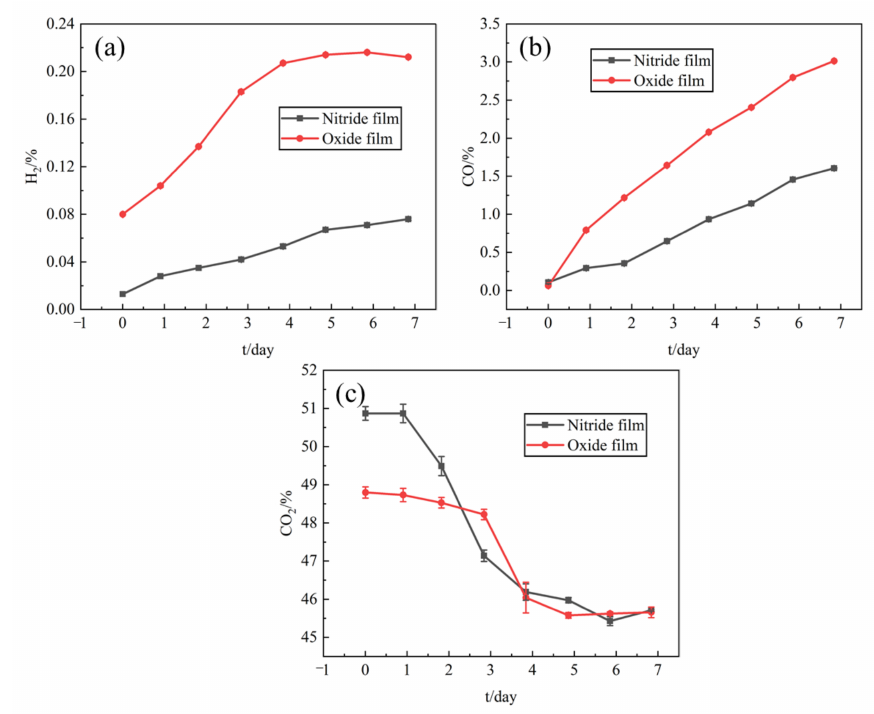
Figure 10. Variation of H 2 , CO, and CO 2 content with time of different films. ( a ) H 2 ; ( b ) CO; ( c ) CO 2 . Table 6. Hydrogen permeation rate of different films.